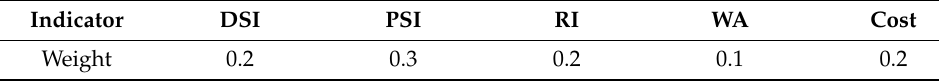
Table 2. Weight factors for MCDA